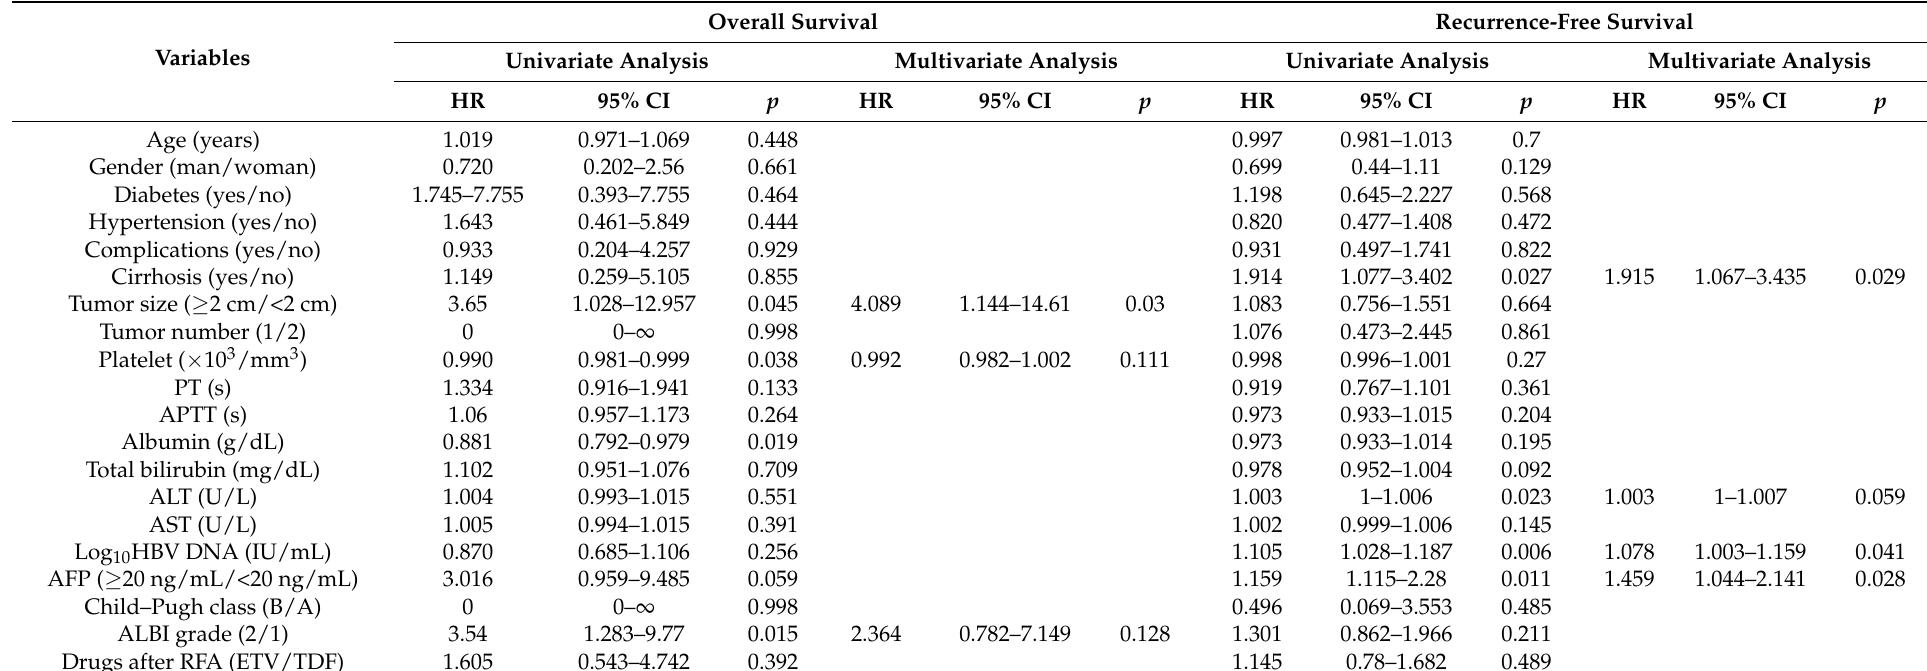
Table 3. Univariate and multivariate analysis of risk factors for overall survival and recurrence- free survival. Overall Variables